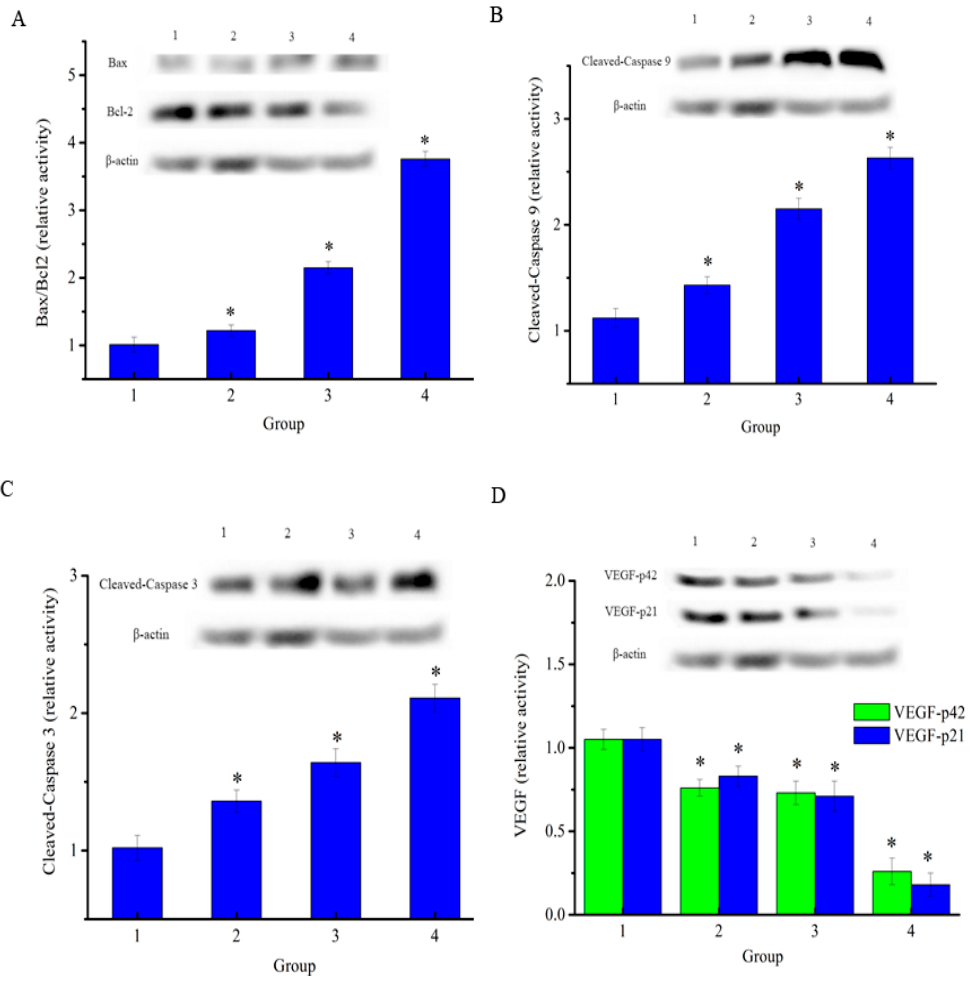
Figure 9. Expression of apoptosis-associated proteins in H1299 cells treated with NAP or DDP. ( A ) Western blotting of Bax and Bcl2 expressed in the treated-H1299 cells and the Bax/Bcl2 ratio; ( B ) Western blotting of cleaved-caspase 9 that expressed in the treated-H1299 cells; ( C ) Western blotting of cleaved-caspase 3 that expressed in the treated-H1299 cells; ( D ) Western blotting of VEGF that expressed in the treated-H1299 cells. The blots were detected with β -actin antibody to determine equal sample loading. * p < 0.05 vs. control. 1: without NAP; 2: treated with 5 mg/kg NAP; 3: treated with 10 mg/kg NAP; 4: treated with 4 mg/kg DDP.